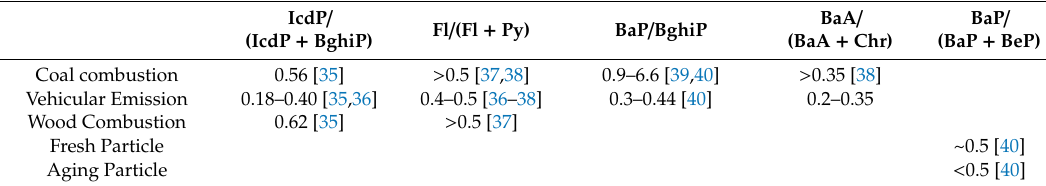
Table 6. Diagnostics Ratio (DR) for anlaysis.